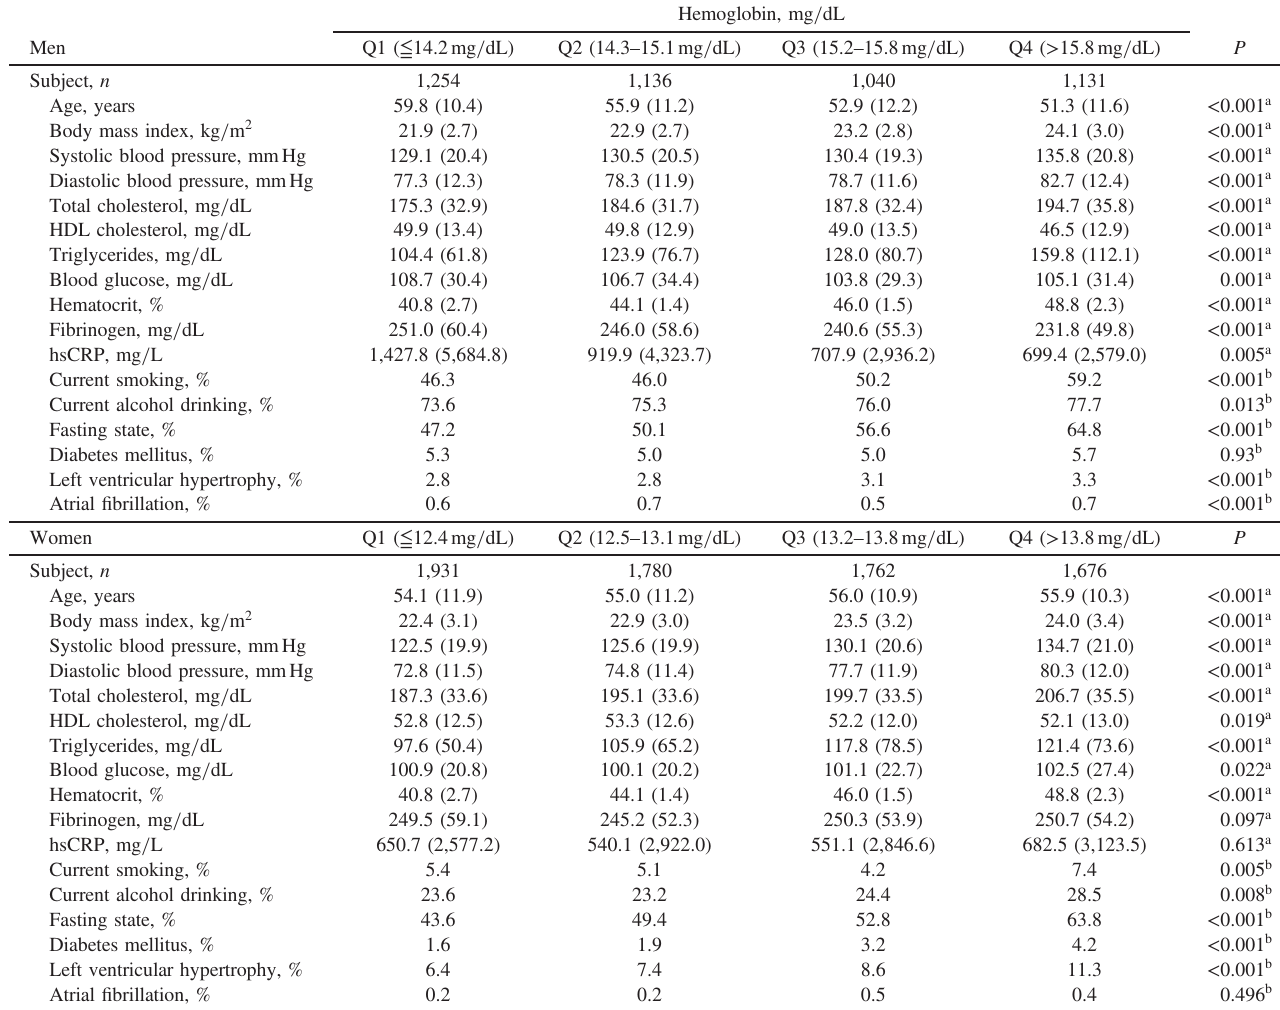
Hemoglobin, mg = dL